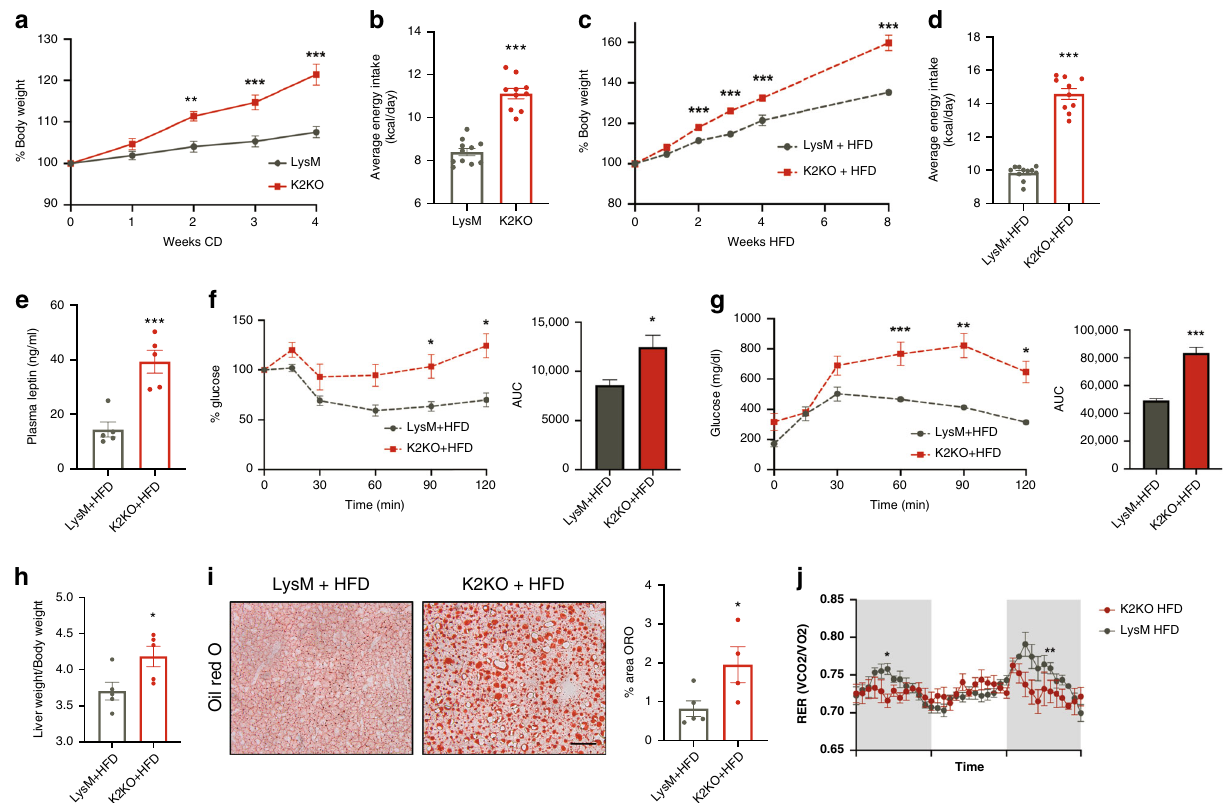
Fig. 2 K2KO mice exhibit signi fi cant metabolic disease at baseline and with HFD. a K2KO mice on control diet (CD) gain weight more rapidly than controls, n = 10, 2 weeks p = 0.0017, 3 and 4 weeks p < 0.0001. b K2KO mice have increased daily food intake in basal conditions, LysM n = 11, K2KO n = 10, p < 0.0001. c High fat diet (HFD) feeding exaggerates the obesity phenotype seen in K2KO mice, LysM n = 10, K2KO n = 12, 2 weeks p = 0.0083, 3 weeks p = 0.0012, 4 weeks p = 0.0133, 8 weeks p = 0.0038. d Increased energy intake in HFD-fed K2KO mice as measured by daily food consumption, n = 10, p < 0.0001. e Increased plasma leptin levels in HFD-fed K2KO mice indicative of increased adiposity and leptin resistance, n = 5, p = 0.0079. f Intraperitoneal insulin tolerance test (IPITT) demonstrates relative insulin resistance in HFD-fed K2KO mice, representative graph of n = 4, validated >3 times. AUC, area under curve, p = 0.0286. g Intraperitoneal glucose tolerance test (IPGTT) reveals relative glucose intolerance in HFD-fed K2KO mice, n = 4, validated >3 times, p = 0.0009. h Liver weight to body weight (BW) ratio demonstrating hepatomegaly in HFD-fed K2KO mice, n = 5, p = 0.0317. i Oil red O (ORO) staining indicating increased lipid accumulation in the livers of K2KO mice fed HFD. Quanti fi cation is of proportional area of ORO + staining, representative images shown, LysM n = 5, K2KO n = 4, p = 0.0456. Scale bar = 100 µ m j Respiratory exchange ratio (RER) from metabolic cage experiments over multiple light-dark cycles, mice were fed one month HFD, n = 4. * p < 0.05, ** p < 0.01, *** p < 0.001 by unpaired, two-tailed Student ’ s t -test, comparisons marked or indicated in fi gure legend. Error bars represent SEM. All mice on were fed CD/HFD for 1 month unless otherwise indicated. Metabolic parameters were also conducted at one month HFD unless otherwise indicated. n represents biologically independent mice throughout entire fi gure. Source data are provided as a Source Data fi